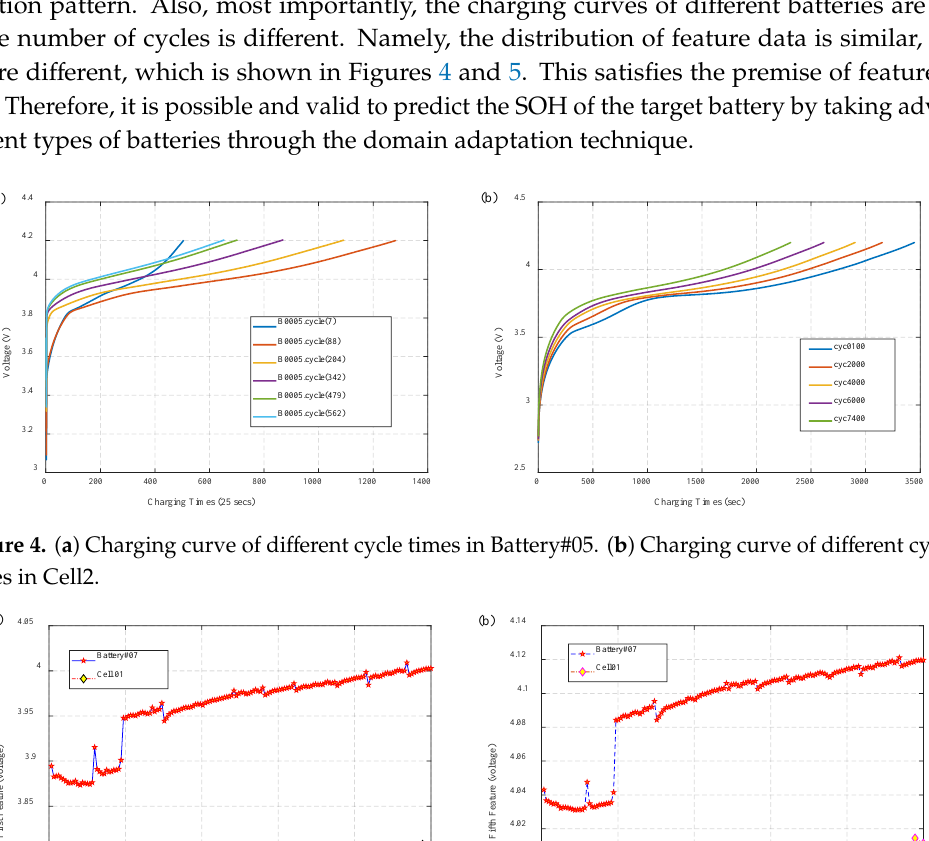
Figure 6. Framework for lithium battery prediction . SLFN—single hidden layer feed forward neural network . As shown in the framework of Figure 6, the deployment of the algorithm will be explained step by step.